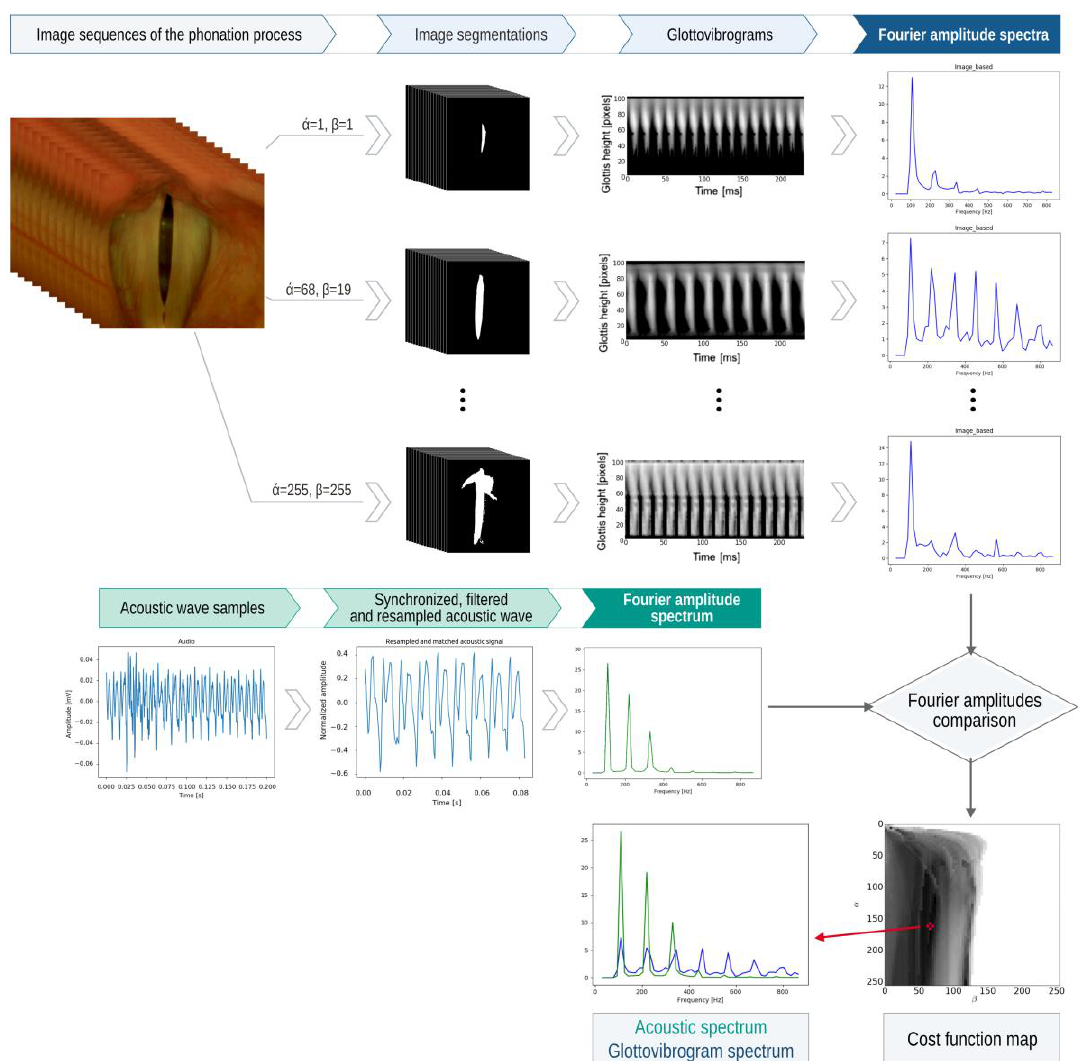
Figure 10. Diagram explaining the designed method of the segmentation of glottal images where, in the search for the best segmentation results, the Fourier spectra derived from the pool of segmented LHSVs are compared to the Fourier spectra of the acoustic